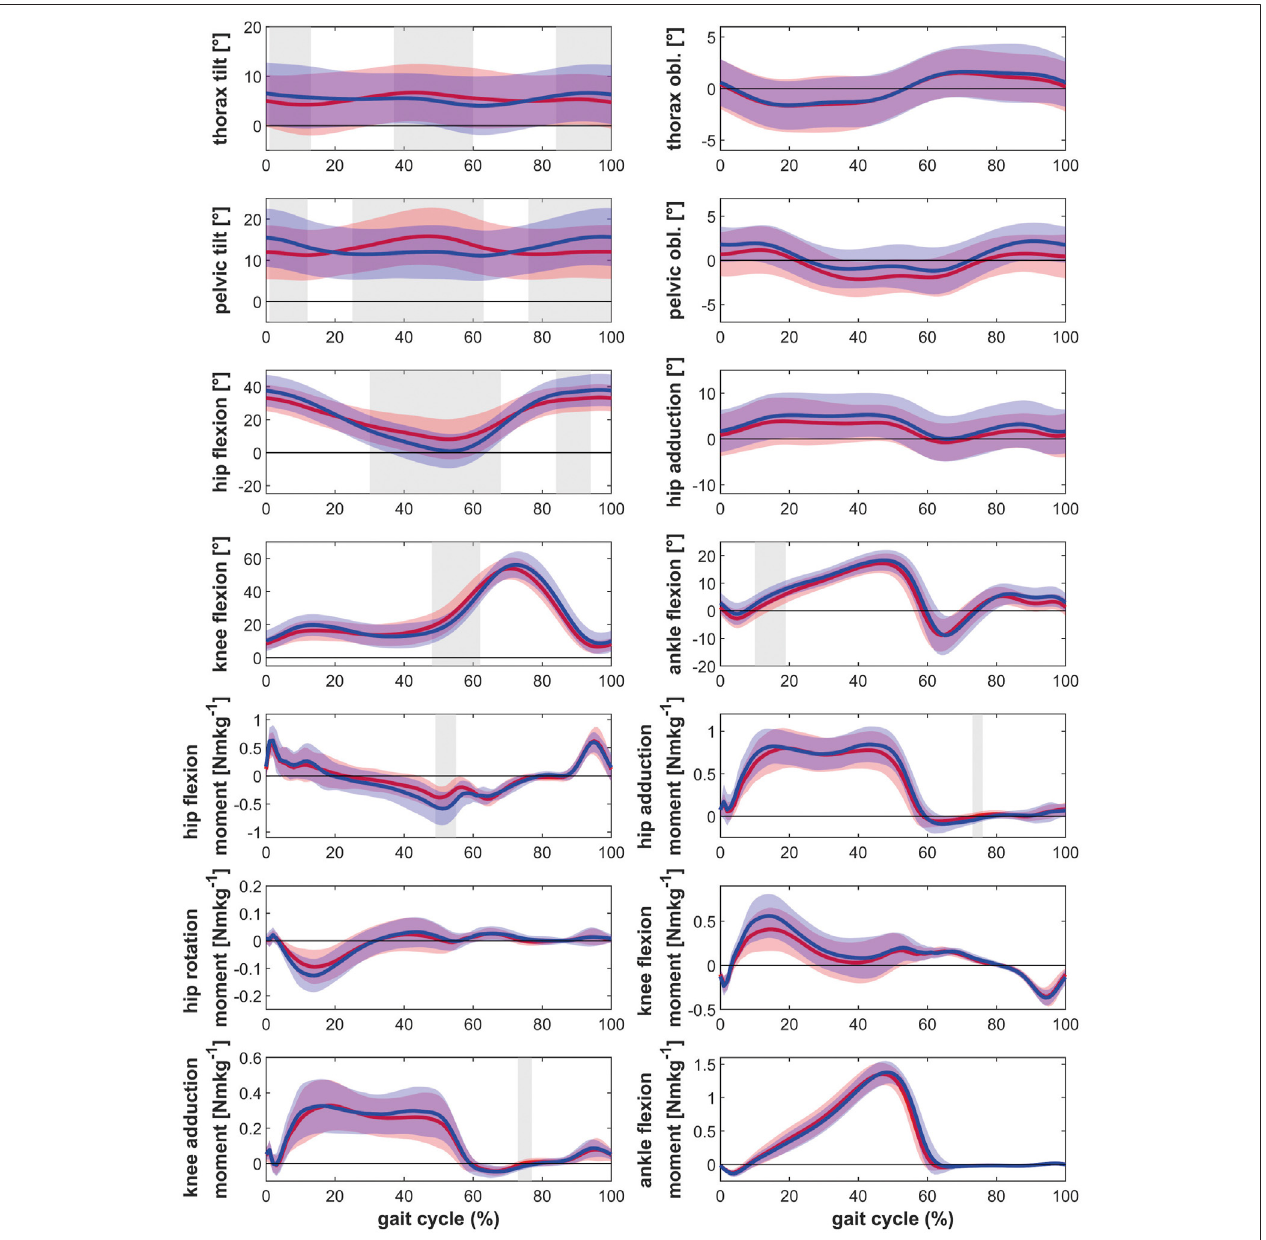
FIGURE5| ComparisonofthekinematicsandkineticsbetweentheipsilateralandcontralaterallegofbilateralhipOApatients.Meanandonestandarddeviationof thejointanglesandtheexternaljointmoments.Shadedareasindicatestatisticaldifferences.Redlines (cid:1) ipsilateralleg,bluelines (cid:1) contralateralleg. (A) thoraxtilt:anterior (+)/posterior ( − ); (B) thorax obliquity: towards the contralateral side (+)/towards the ipsilateral side ( − ); (C) pelvic tilt: anterior (+)/posterior ( − ); (D) pelvic obliquity: up (+)/down ( − ); (E) hip fl exion/extension: fl exion (+)/extension ( − ); (F) hip adduction/abduction: adduction (+)/abduction ( − ); (G) knee fl exion/extension: fl exion (+)/extension ( − ); (H) ankle dorsi fl exion/plantar fl exion: dorsi fl exion (+)/plantar fl exion ( − ); (I) hip fl exion/extension moment: fl exion (+)/extension ( − ); (J) hip adduction/ abduction moment: adduction (+)/abduction ( − ); (K) hip rotation moment: internal rotation (+)/external rotation ( − ); (L) knee fl exion/extension moment: fl exion (+)/extension ( − ); (M) knee adduction/abduction moment: varus (+)/valgus ( − ); (N) ankle dorsi fl exion/plantar fl exion moment: dorsi fl exion (+)/plantar fl exion ( − ).